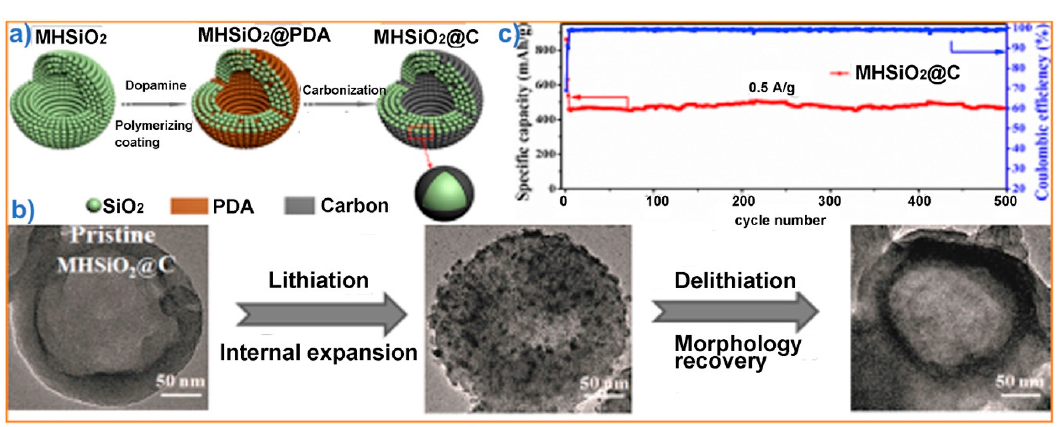
Figure 5. Example showing the use of HSPs made by assembling carbon-coated nanoparticles as battery anodes: ( a ) formation of carbon-coated HSPs; ( b ) dilithiation cycle showing expansion and contraction of carbon-coated HSPs; and ( c ) plot showing the cyclic stability of the anode. PDA: polydopamine. Adapted from [101], with permission from Elsevier (2017).